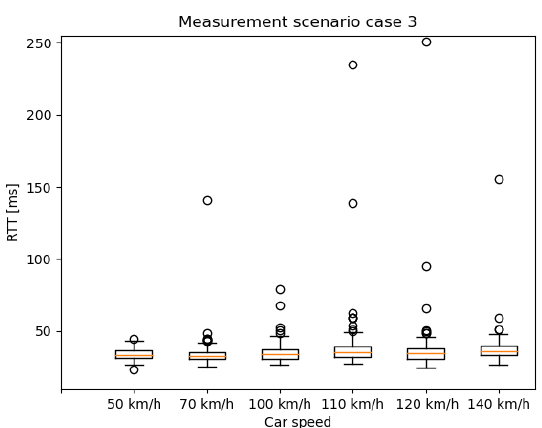
Figure 12. RTT results of measurement with different car speeds—scenario 3: from 10 ms IAT and 700 Byte PL, to 610 ms IAT and 11,200 Byte PL, increment the PL by 700 Byte for every iteration and the IAT by 200 ms for every fourth iteration.